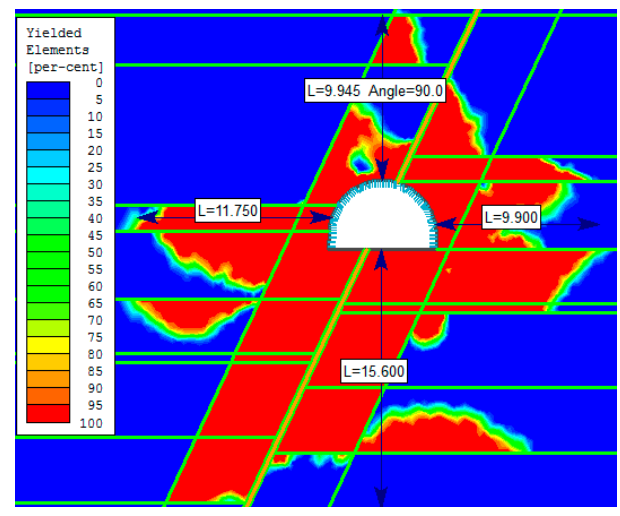
Figure 19. Model no. 7—Fault zone, joint type contact, rigid support—map of yielded rock mass elements around the roadway.